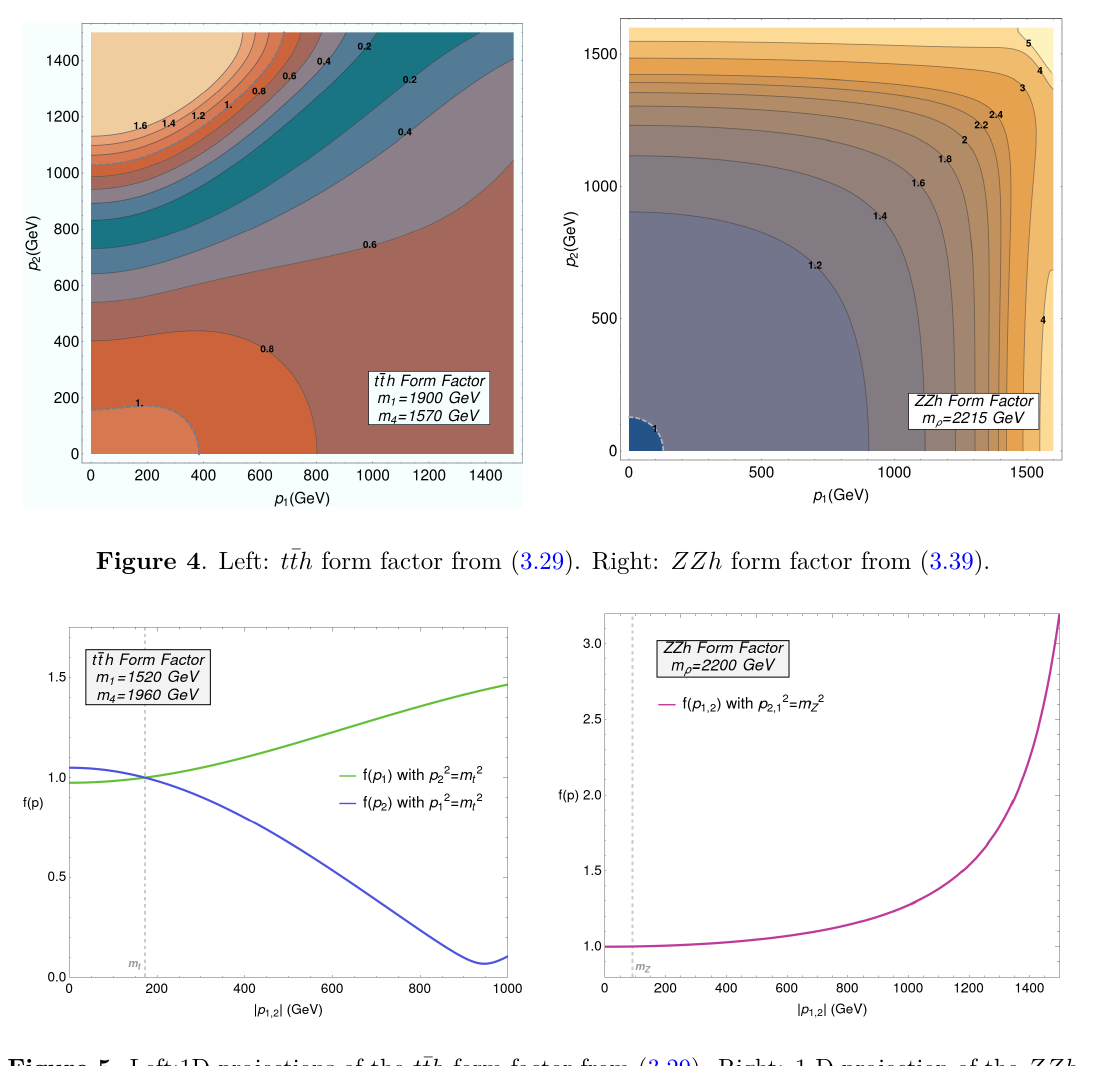
Figure 5 . Left:1D projections of the t ¯ th form factor from (3.29). Right: 1 D projection of the ZZh form factor from